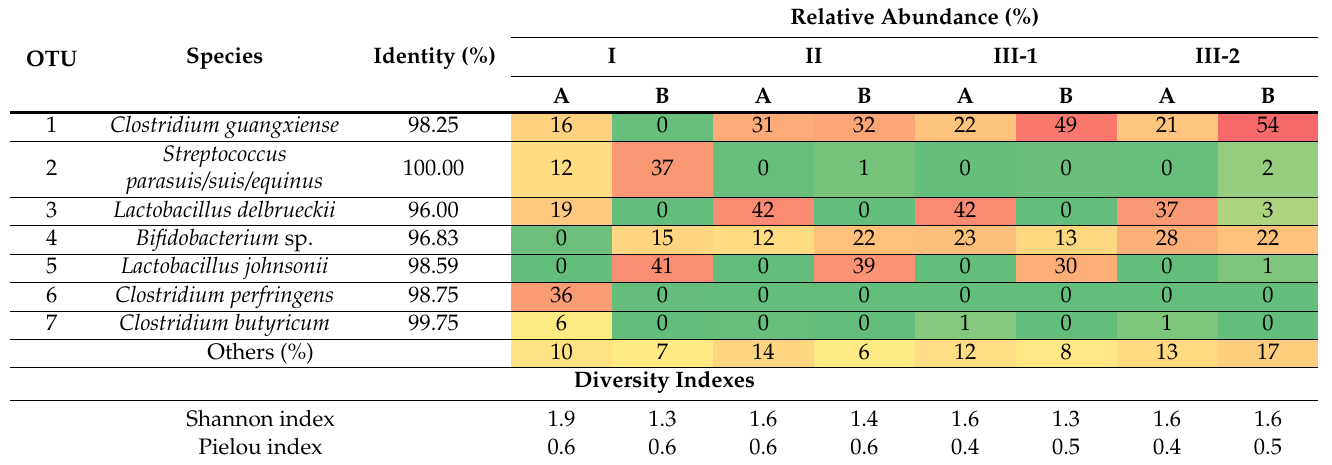
Table 3. Species abundances in periods I, II, III-1, and III-2, in conditions A and B, and diversity